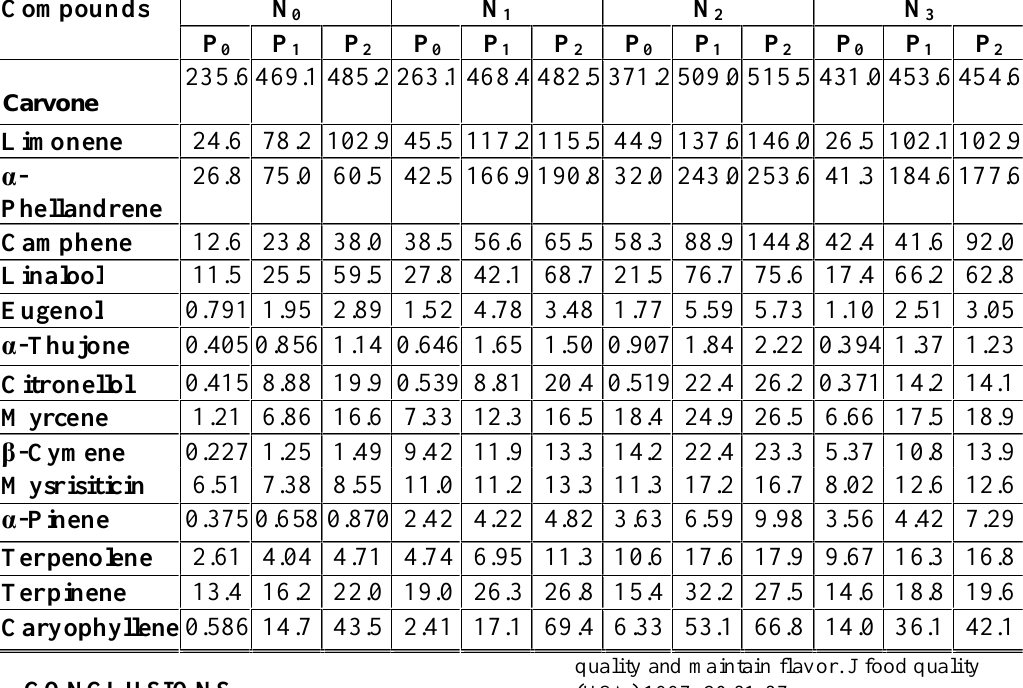
Table 3. Interactive effect of nitrogen and phosphorus levels on dill seed oil